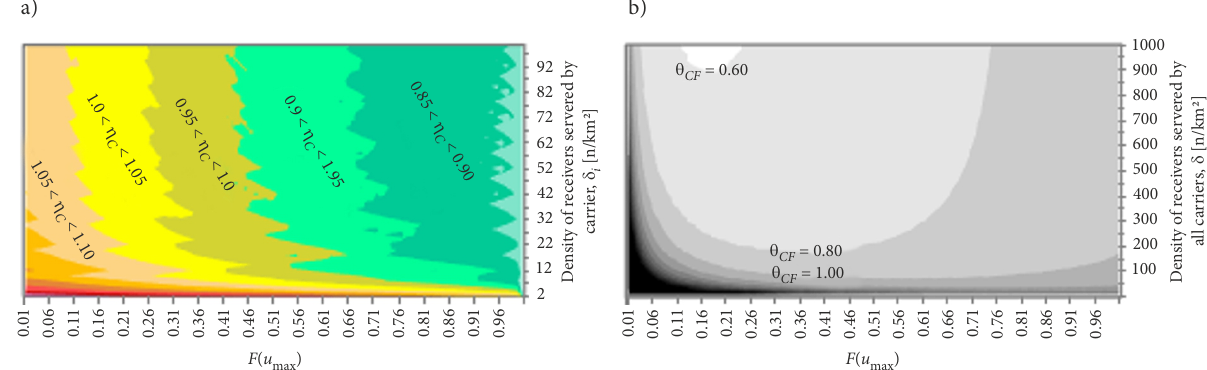
Figure 7. Results in Scenario 2.3 ( C CF = 1.2 m 3 ) with MinFare criterion: a – h C ratio; b – fare q CF